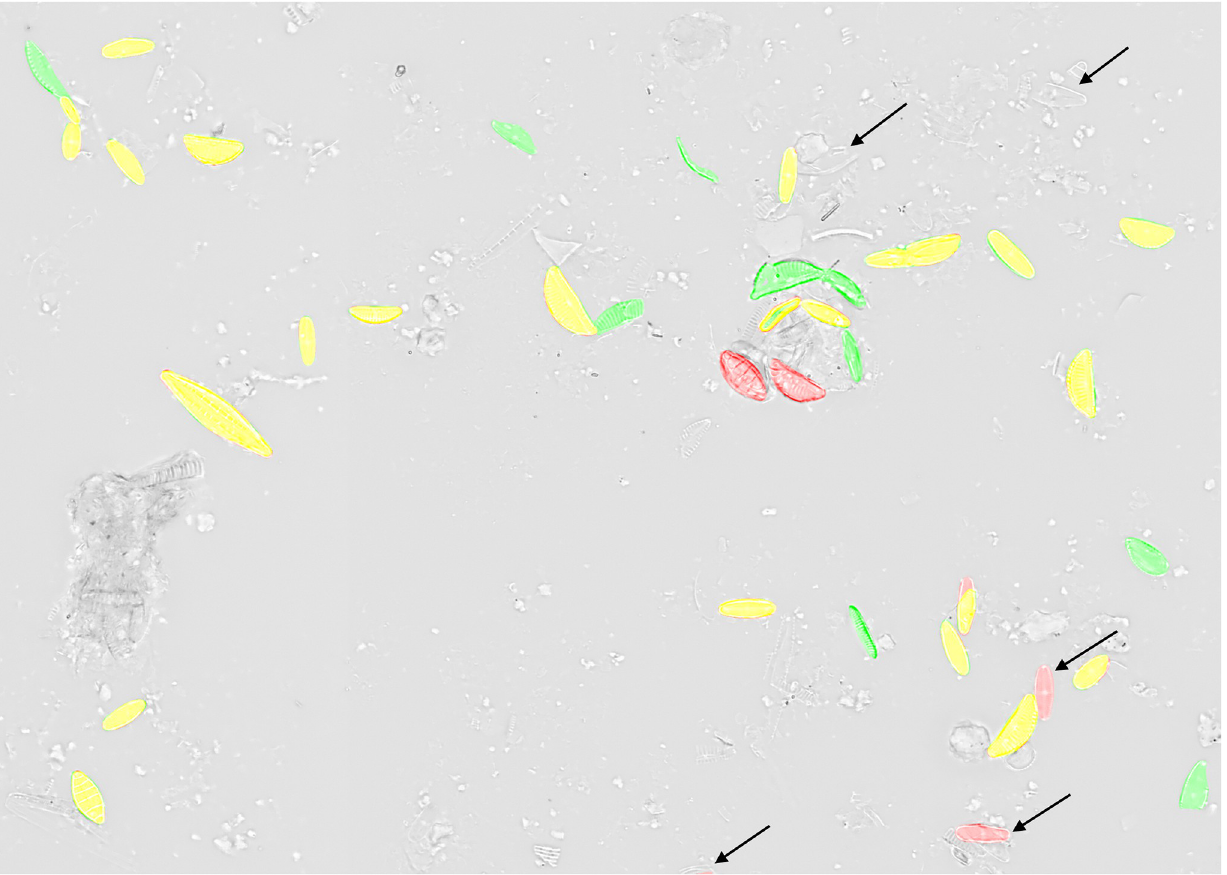
Fig 10. Comparison of predicted segmentation vs. ground truth for a Mask R-CNN model (object-based tile positioning + object integrity constraint, 100% training data) applied with a prediction score threshold of 0.98 on previously unseen test data. Black arrows indicate substantial changes in comparison to Fig 9 (prediction score threshold of 0.9). Yellow = true positive, red = false negative, green = false positive.